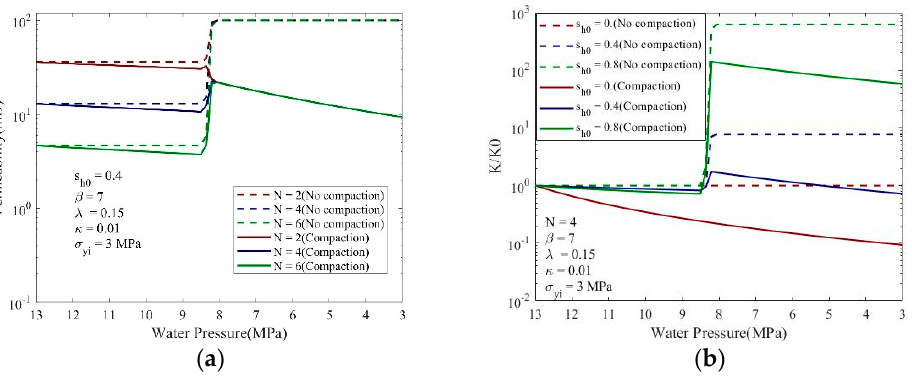
Figure 6. The effect of parameter N on ( a ) permeability and ( b ) permeability ratio.